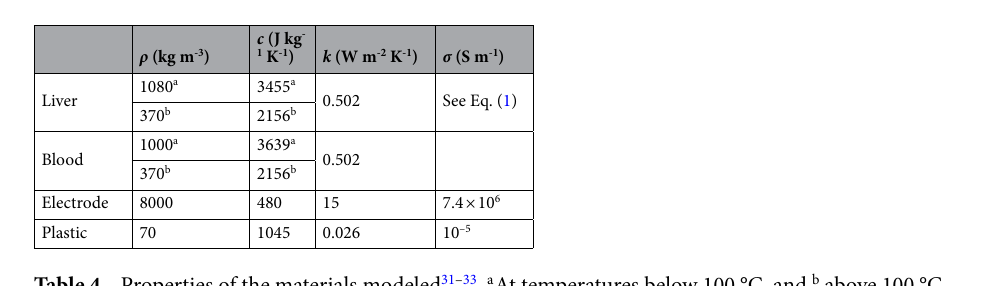
Table 4. Properties of the materials modeled 31–33 . a At temperatures below 100 °C, and b above 100 °C.